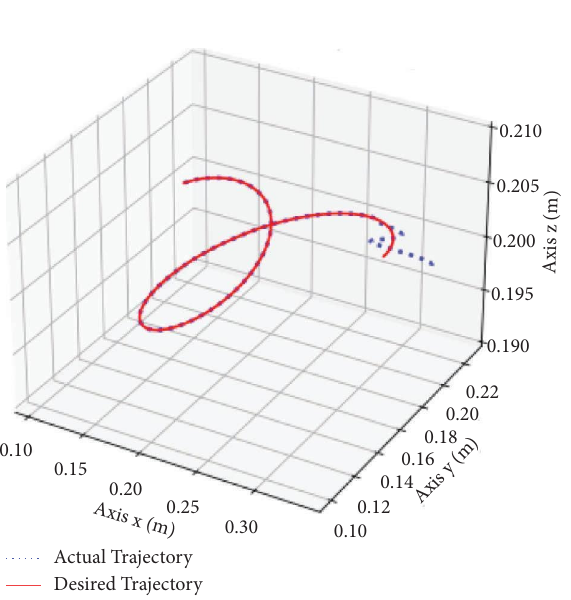
Figure 6: Desired and actual trajectories in the